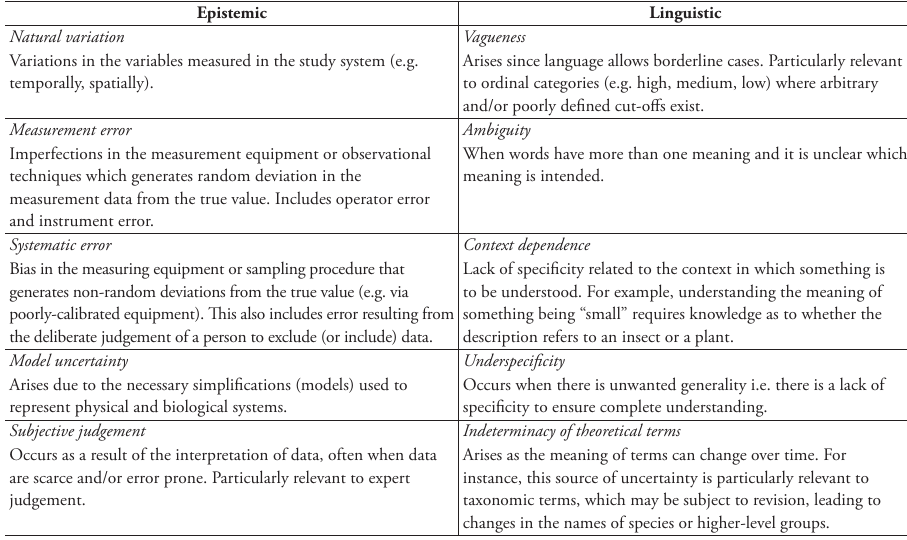
Table 2. Different types of epistemic and linguistic uncertainties and their definitions which are relevant to the ICAT assessment process (Regan et al. 2002). Epistemic Linguistic Natural